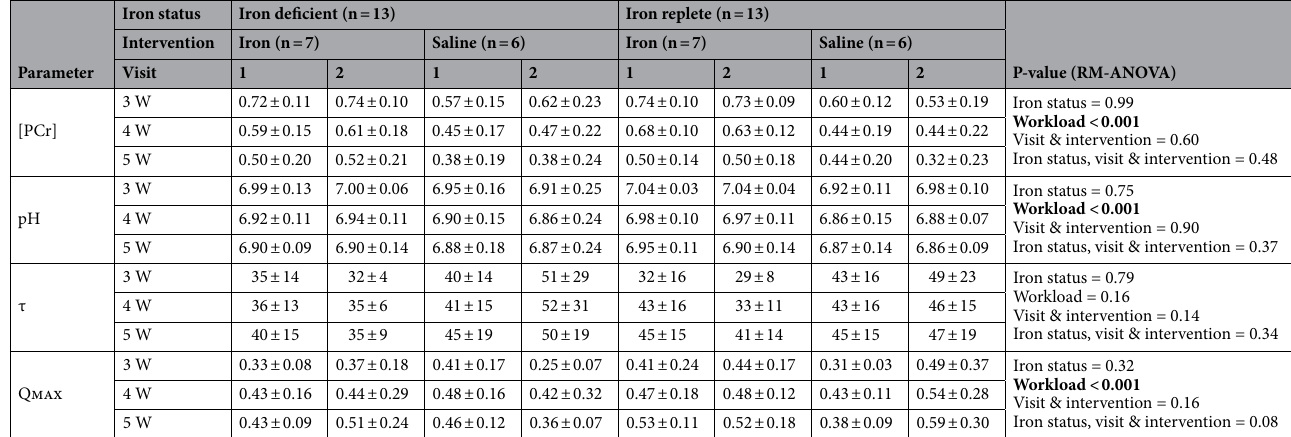
Table 3. Parameters derived from monoexponential fitting of PCr recovery data. Values are given at three different workloads (3 W, 4 W and 5 W) for: (i) [PCr], phosphocreatine concentration at end exercise, expressed as a fraction of the resting level to which it subsequently recovered; (ii) pH at end exercise; (iii) τ, measured in seconds; and (iv) Qmax, measured in mM of ATP per second. For individuals stopping work prematurely owing to fatigue, recovery kinetics were modelled from cessation of exercise. Values are means ± SD. Statistically significant P-values appear in bold.